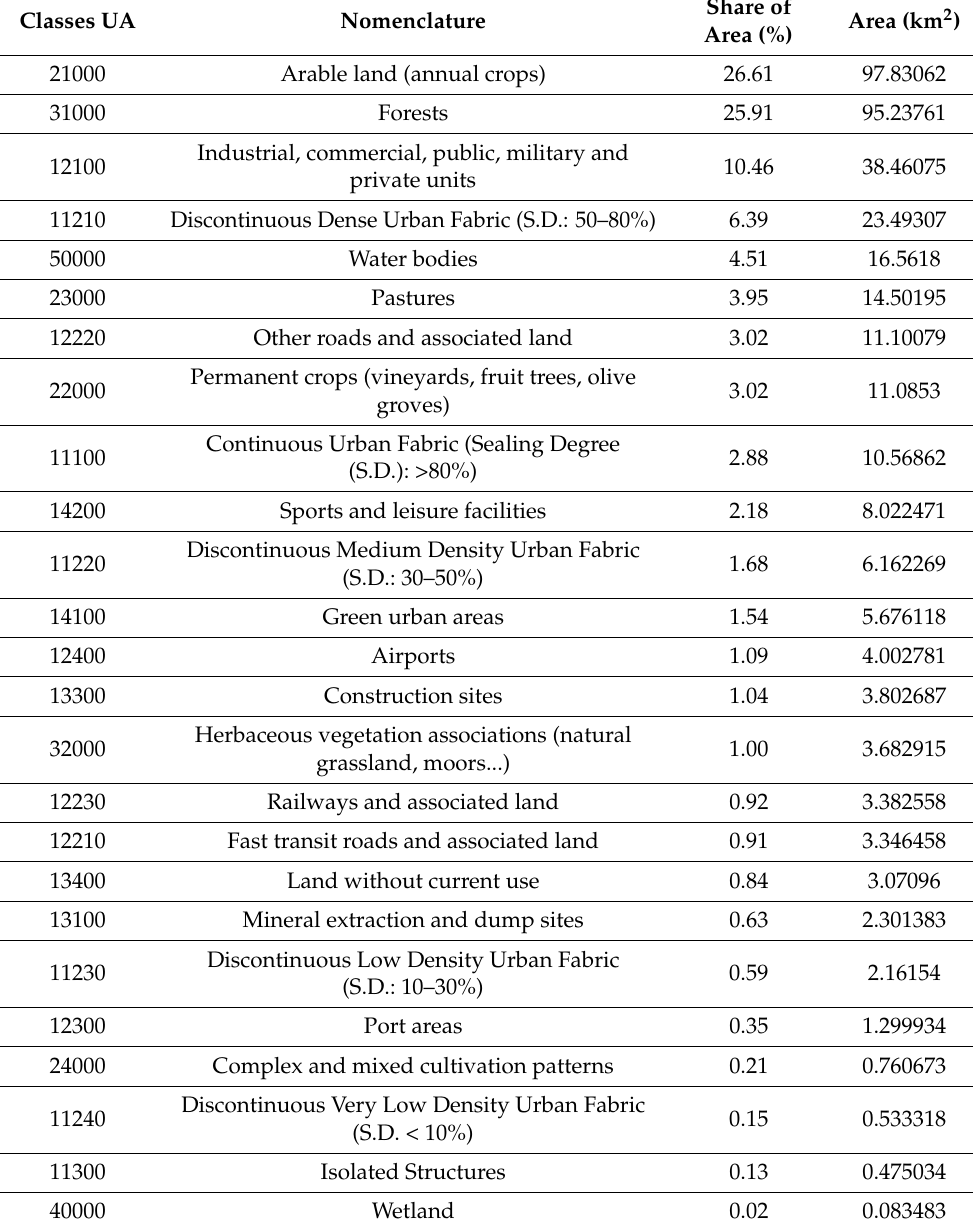
Table 1. Representation of Urban Atlas Land Cover Classes in the City of